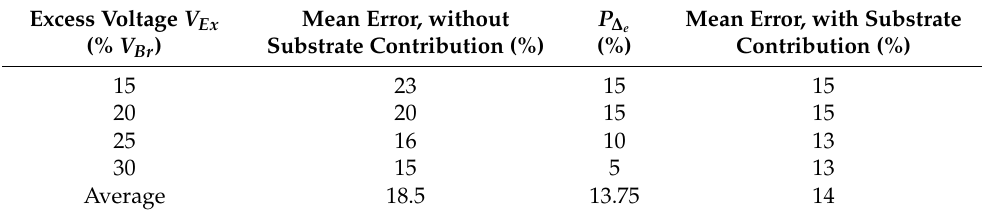
Table 2. Mean error between measured and simulated-filtered PDP for simulations performed with and without the substrate contribution P Sub